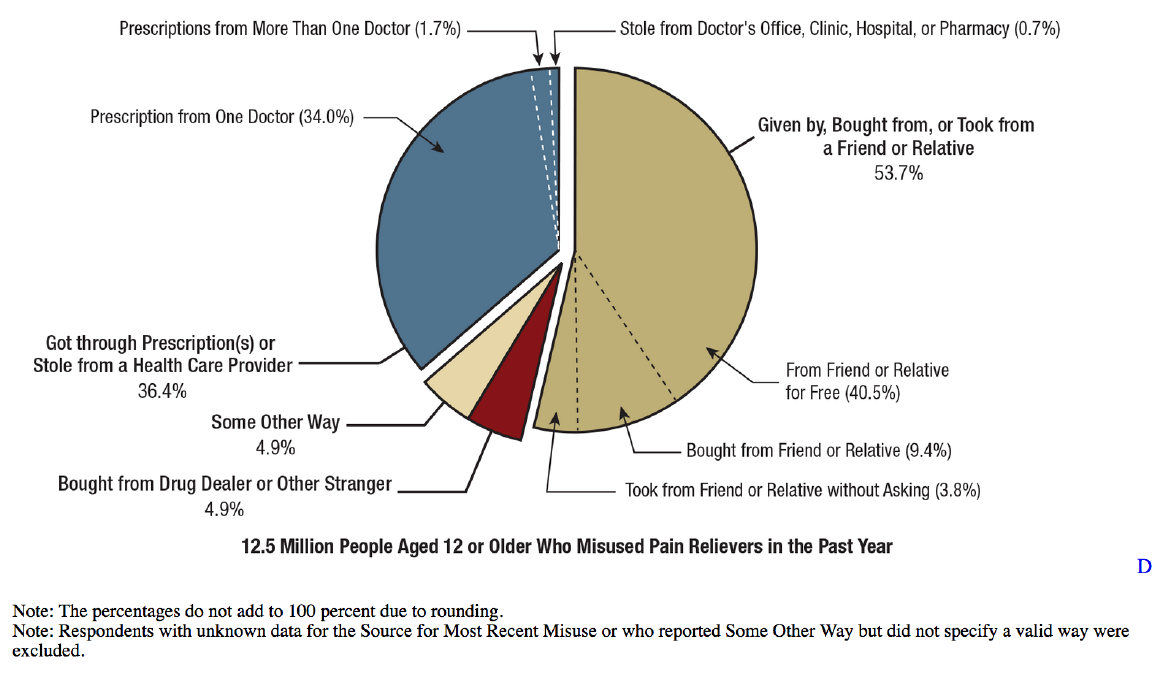
Figure 2. Source where pain relievers were obtained for most recent misuse among people aged 12 or older who misused prescription pain relievers in the past year: percentages,